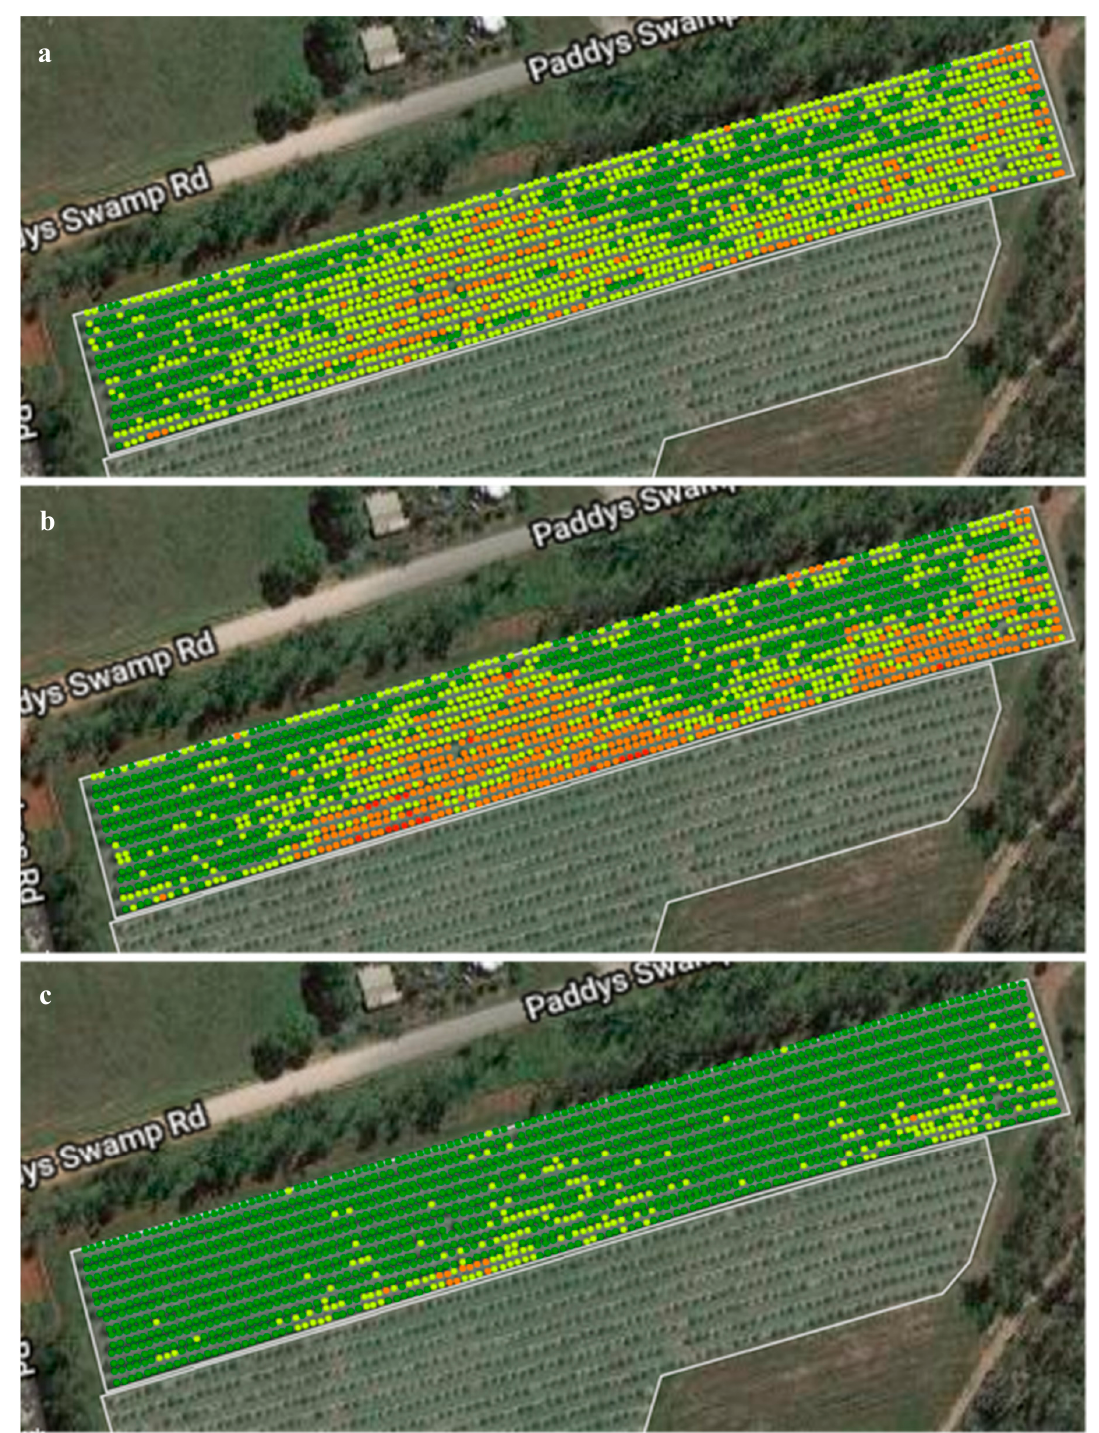
Figure 14. Data of the imaging run of week-1 of Orchard A, in terms of number of panicles at stages ( a ) X, ( b ) Y and ( c ) Z. Dark green, light green, orange and red colours correspond to < 30; 30 to 70, 70 to 100 and > 100 panicles per tree image.